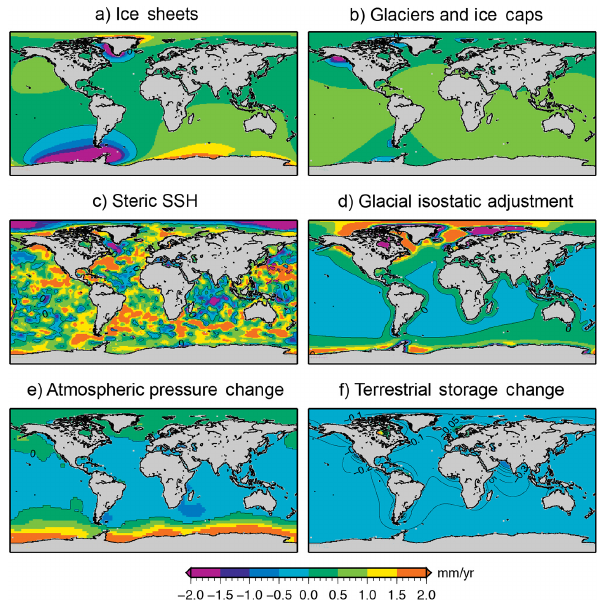
Figure 2. Regional sea-level trends (mmyr − 1 ) over the pe- riod 1961–2003 for the following contributions; (a) ice sheets, (b) glaciers and ice caps, (c) steric change, (d) glacial isostatic ad- justment, (e) atmospheric pressure loading, and (f) terrestrial wa- ter storage change from groundwater extraction and reservoir im- poundment. The black line is zero-contour, except in (f) where ev- ery 0.05 contour is shown for clarity. This accompanies the global mean trends in Table 2. All data are on a 1 × 1 degree grid, with an ocean surface area of 3 . 50 × 10 14 m 2